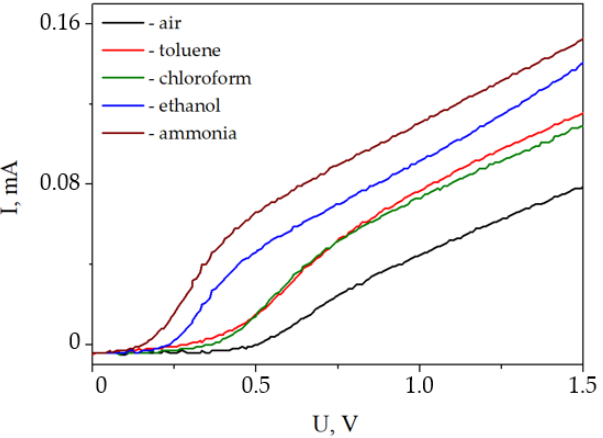
Figure 3. The current–voltage characteristics of CuO/PS-based gas sensor in the presence of various gas types.